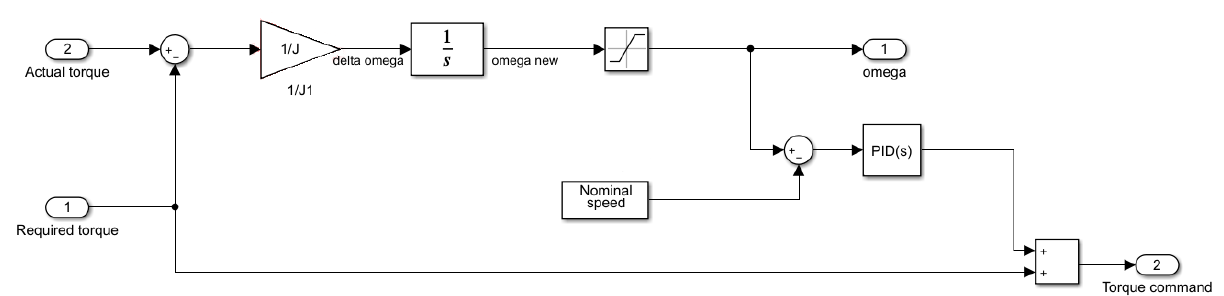
Figure 3. Shaft balance block.